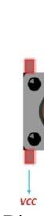
Figure 8. Pinout of push button